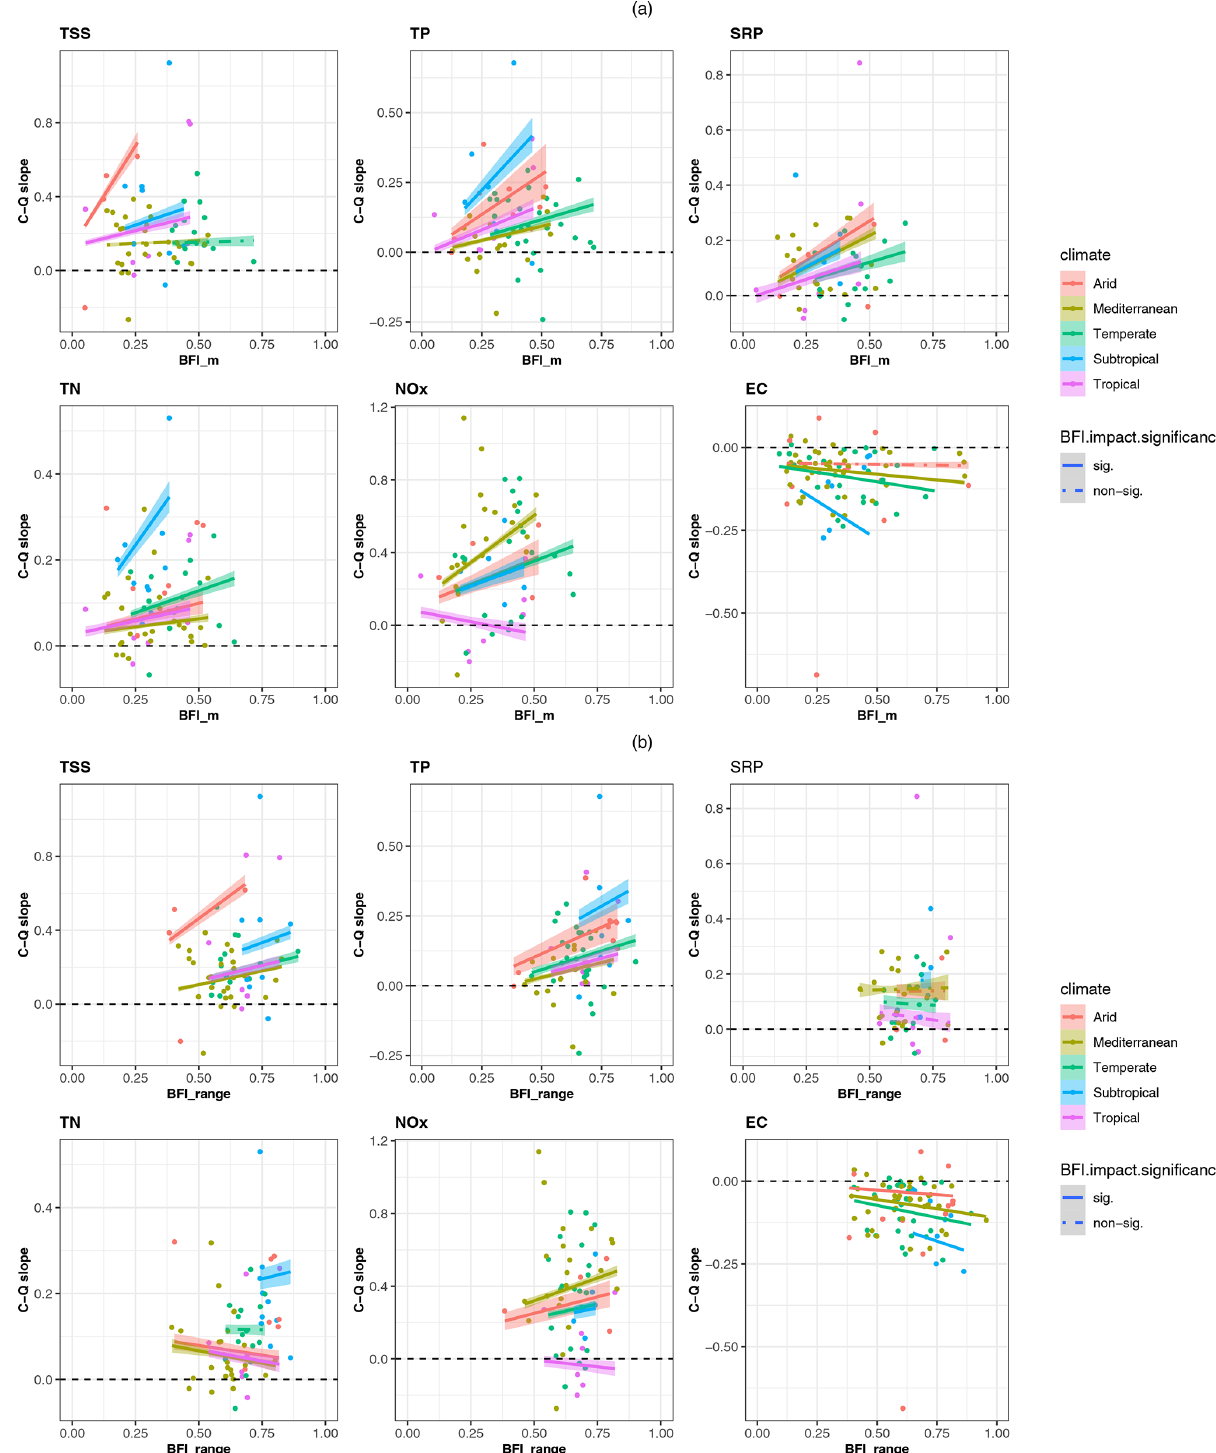
Figure 6. (a) Catchment C – Q slope vs. BFI_m and (b) catchment C – Q slope vs. BFI_range, coloured by climate zones. The lines represent the modelled C – Q slope–BFI_m or C – Q slope–BFI_range regression lines for individual climate zones. The bands represent the 95% credible interval (the range between 2.5th to 97.5th percentiles of Bayesian posterior distribution) of the modelled C – Q slopes. The dots represent the “true” C – Q slopes estimated with C – Q observations at individual catchments. The dashed black lines mark a zero C – Q slope which differentiates mobilization ( C – Q slope > 0) from dilution ( C – Q slope < 0).